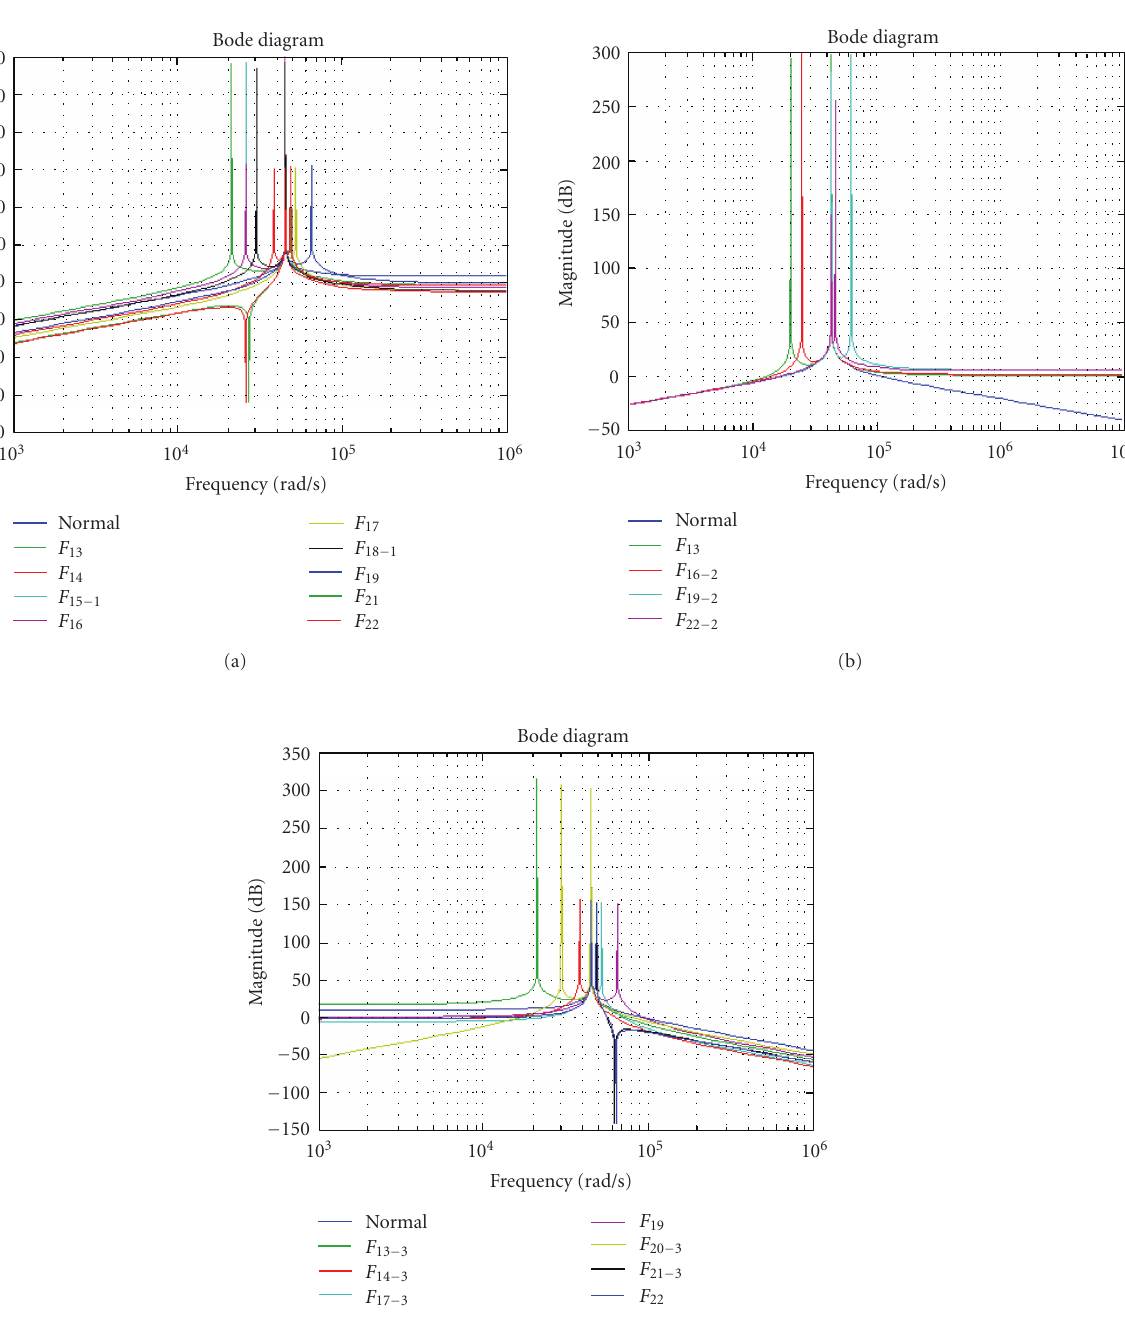
Figure 11: Response of the multiple faults at (a) node 1, (b) node 2, (c) node